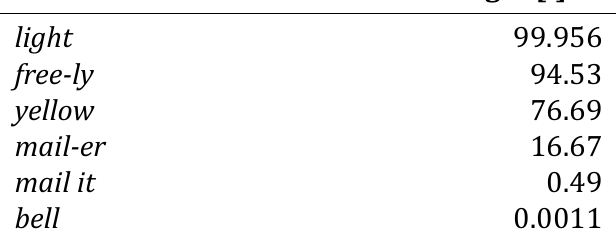
Table 4: Adapted from Boersma & Hayes